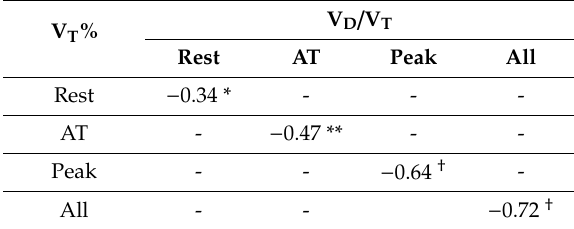
Table A2. Pearson correlations (r) pairwise deletion between dead space and tidal volume ratio (V D / V T ) and tidal volume and total lung capacity ratio (V T %) at di ff erent phases of exercise test in participants with chronic obstructive pulmonary